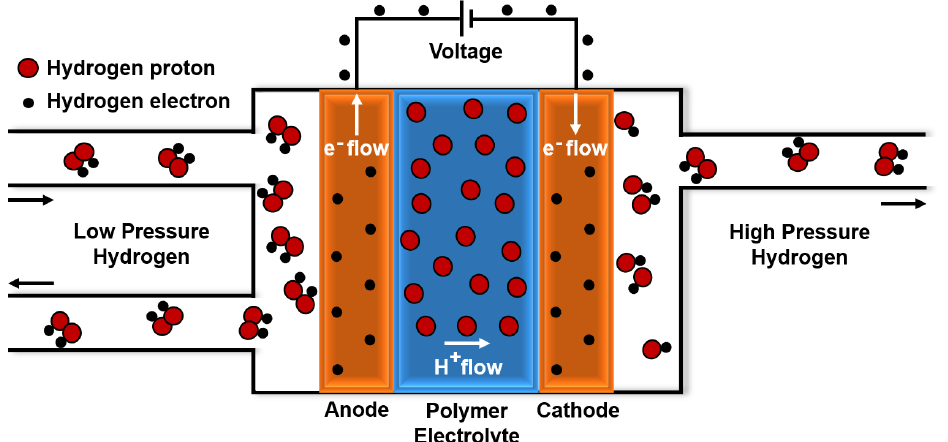
Figure 1. How an Electrochemical Hydrogen Compressor works: the polymer electrode membrane is positioned between two catalysts containing electrodes and allows the H2 protons to move from the left to the right side. H2 electrons flow in the same direction by a power supply. Then, at the cathode, the protons and electrons form hydrogen again, but at higher